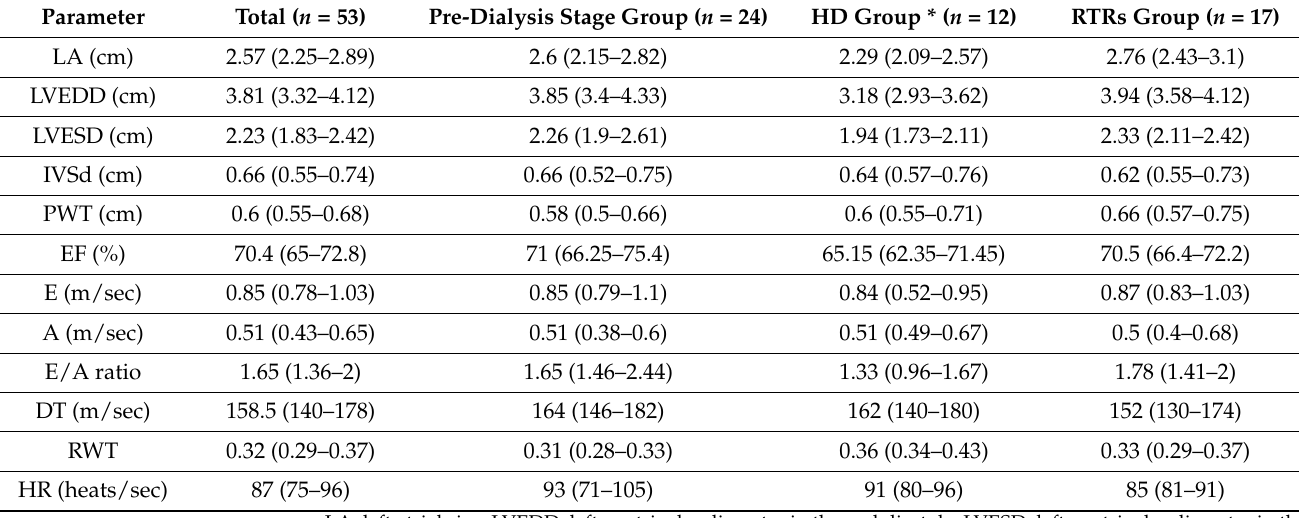
Table 2. Cardiac parameters’ values in CKD